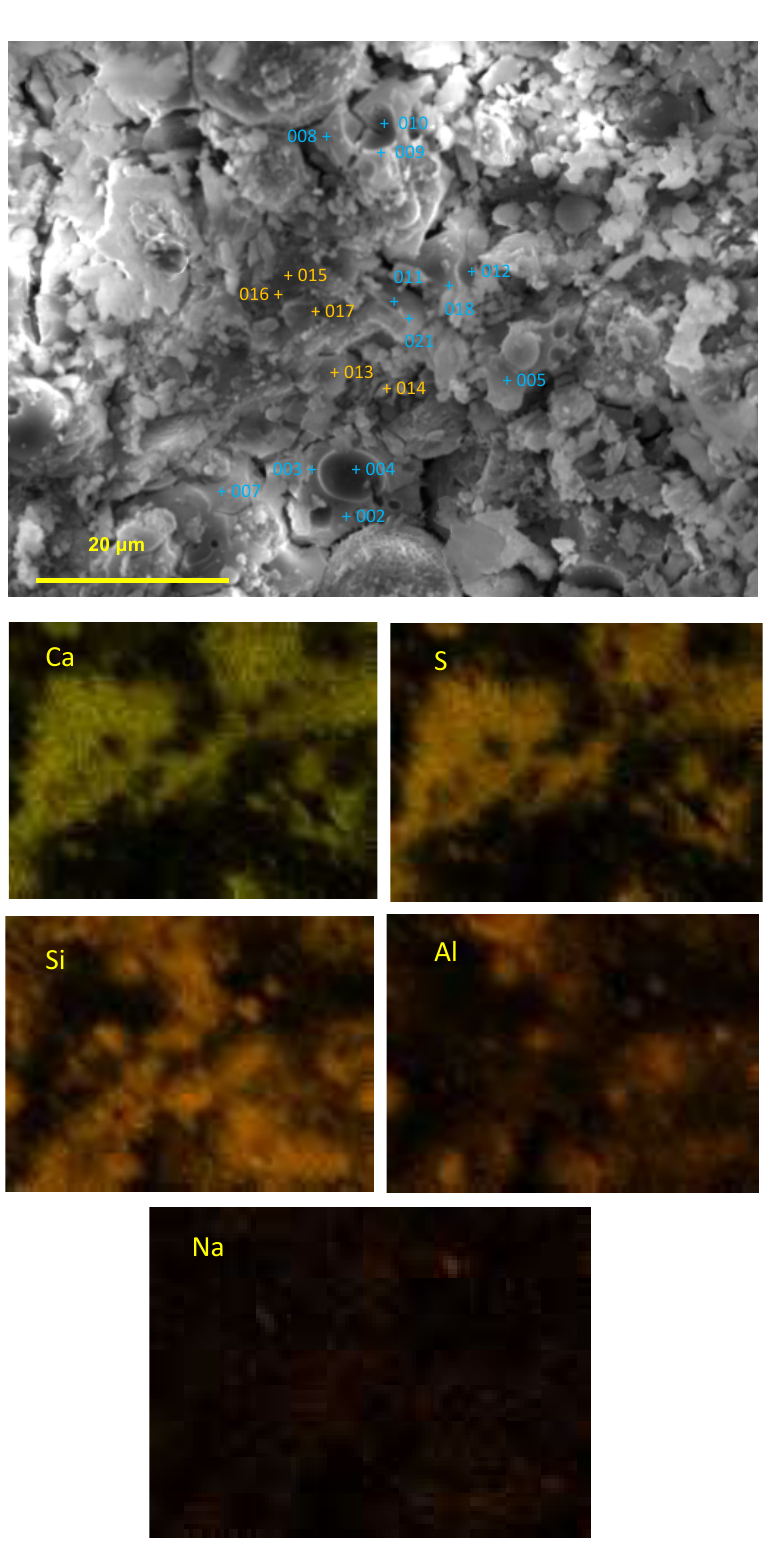
Figure 19. Point analysis and elemental mapping of the outer area of the AS21-45 specimens after sulfuric acid immersion.